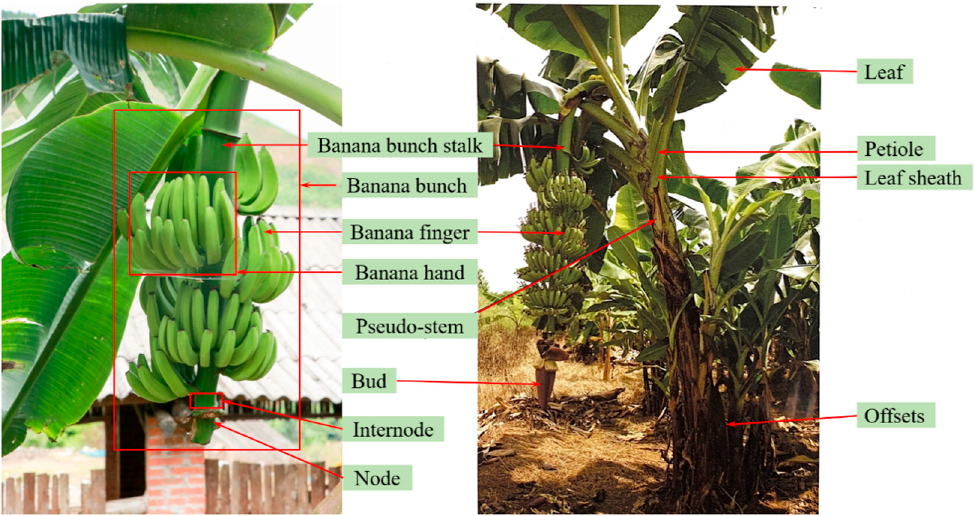
Figure 2. Morphological characteristics of the aboveground parts of the banana